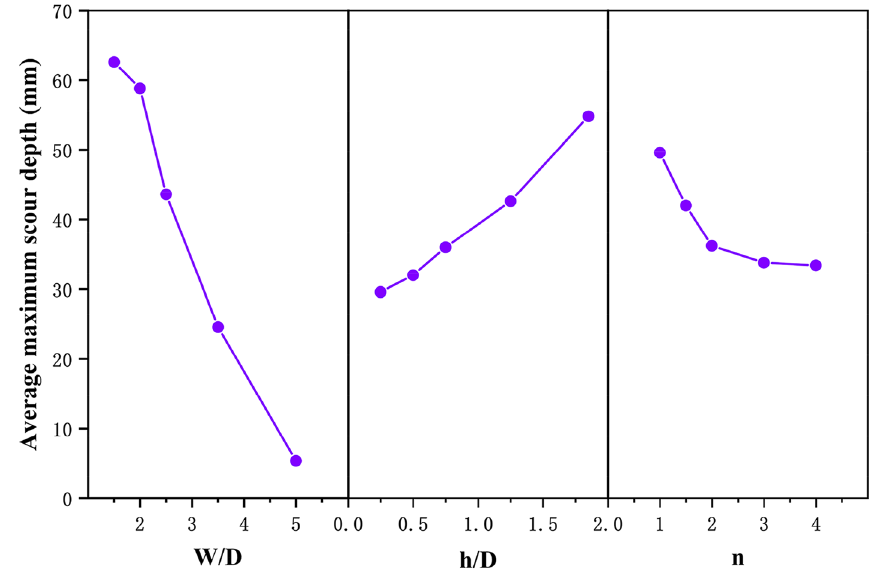
Fig. 8 Main effect plot of the maximum scour depth around the